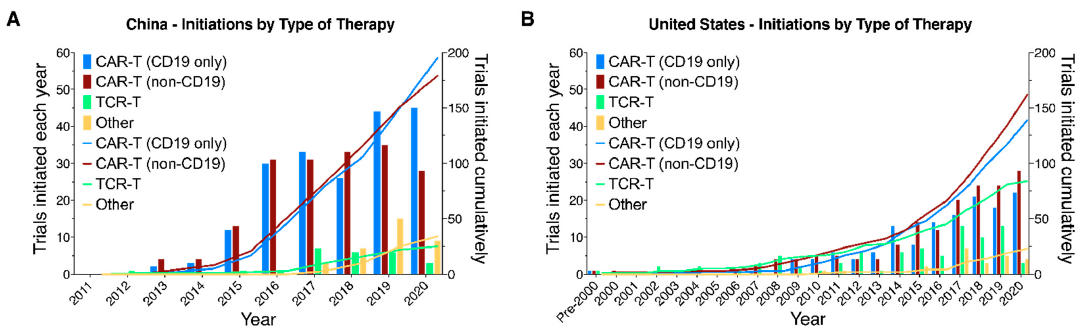
Figure 4. Number of CAR-T clinical trials by originators from China surpassed the number of clinical trials by originators from the United States. Yearly (bars) and cumulative (lines) numbers of CAR-T/TCR-T trials registered on clinicaltrials.gov and initiated on or before 31 December 2020. CAR-Ts are divided into those targeting CD19 (either alone or in combination with other antigens) and all other trials. ( A ) China-based and ( B ) United States-based clinical trial originators.